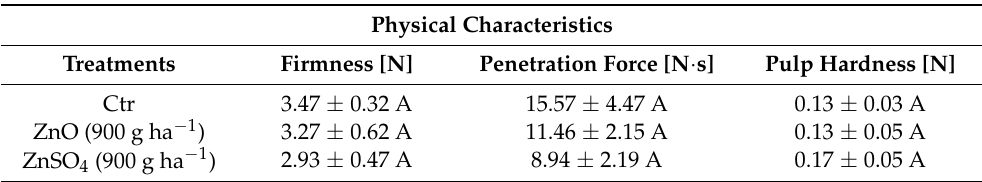
Table 6. Mean values ± SE (n = 3) of firmness, penetration force, and pulp hardness in Vitis vinifera L. grapes variety Fern ã o Pires. Letter A indicates the absence of significant differences between treat- ments (statistical analysis using the single-factor ANOVA test, p ≤ 0.05).